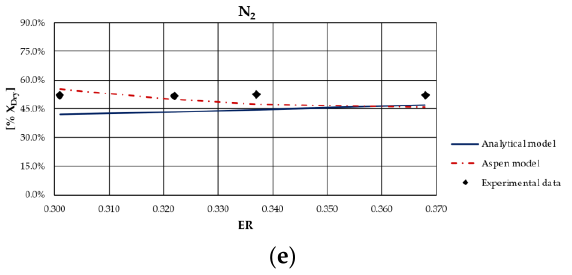
Figure 8. Comparison of syngas mole fraction composition between the results of analytical and Aspen models and experimental data from coniferous wood gasification [69]: ( a ) CH 4 mole fraction; ( b ) H 2 mole fraction; ( c ) CO mole fraction; ( d ) CO 2 mole fraction; ( e ) N 2 mole fraction.